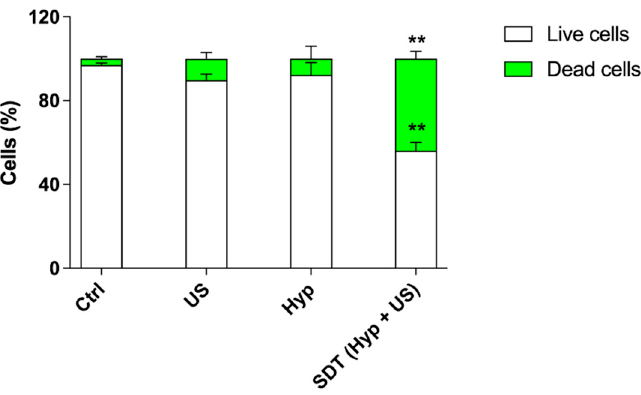
Figure 14. Cell death evaluation after Hyp-mediated sonodynamic treatment in HT-29 spheroids. HT-29 spheroids were previously incubated with 0.2 μ M Hyp and then exposed to US (1.5 W/cm 2 at 1.5 MHz, continuous wave mode for 5 min). Cell death was evaluated by flow cytometry using SYTOX™ green dead cell staining and expressed as cell percentage. Statistically significant difference versus untreated cells (Ctrl): ** p ≤ 0.01 ( n = 3).